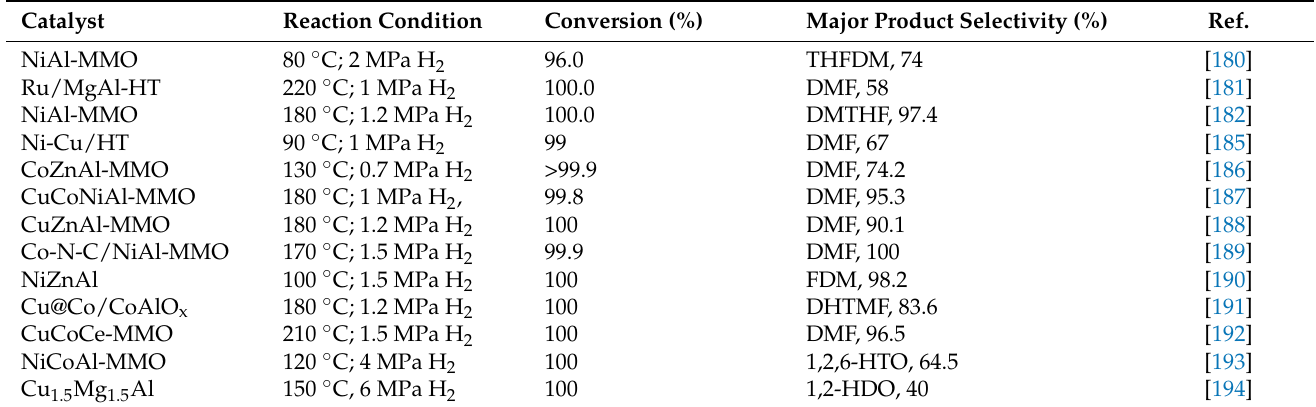
Table 3. Catalytic performances of LDH-derived catalysts for 5-hydroxymethylfurfural hydrodeoxygenation 1